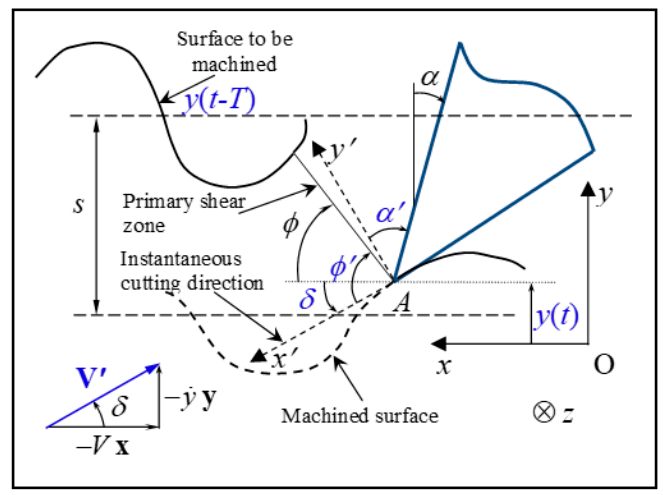
Figure 1. Tool–workpiece interaction during the dynamic cutting process, which was assimilated to a single degree of freedom in the feed direction ( y -direction). The stationary cutting parameters (i.e., without vibrations) α , V , s , and φ represent the tool rake angle, the cutting speed, the uncut thickness, and the shear angle, respectively. y ( t ) is the tool displacement during the tool vibrations.